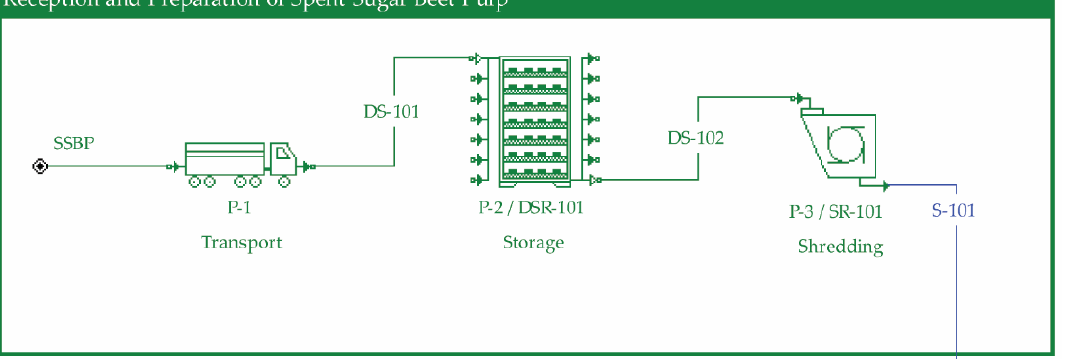
Figure 1. Process flow diagram of the process of bioethanol production from spent sugar beet pulp, consisting of reception (transportation and storage) and preparation (shredding) stages.